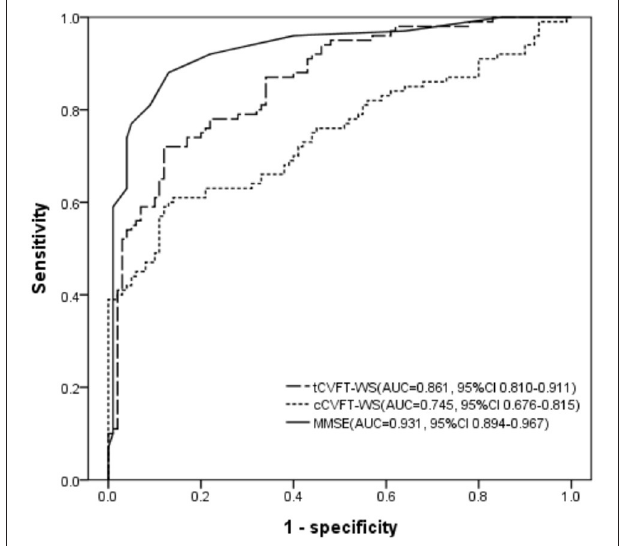
FIGURE 1 | Receiver operating characteristic curve, regarding early AD, of the semi-automatically administered categorical verbal fluency test, conventionally administered categorical verbal fluency test, and Mini-Mental State Examination. tCVFT-WS, semi-automatically administered categorical verbal fluency test weighted sum score; cCVFT-WS, conventionally administered categorical verbal fluency test weighted sum score; MMSE, Mini-Mental State Examination; AUC, area under the receiver operating characteristic curve; CI, confidence